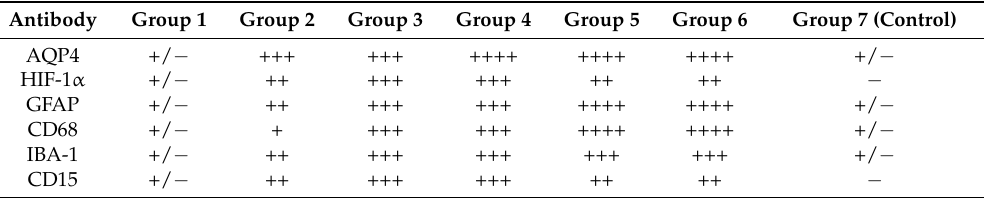
Table 2. Semiquantitative evaluation and statistical analysis of the immunohistochemical findings and gradation of the immunohistochemical reaction in the brain